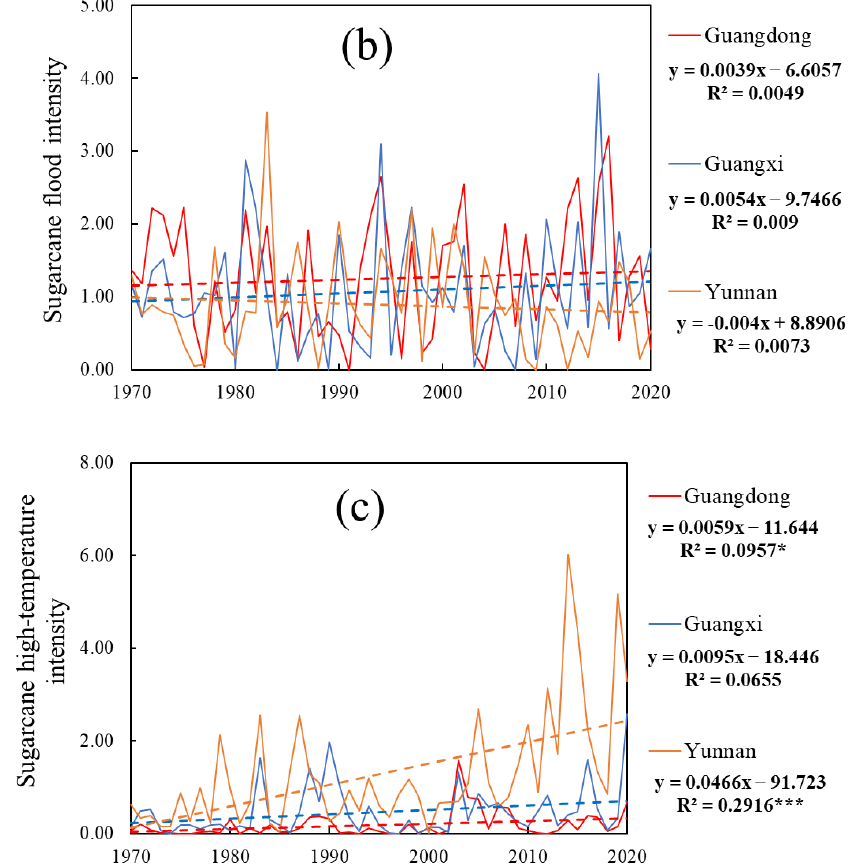
Figure 4. Temporal trends of drought ( a ), flood ( b ), and high temperatures ( c ) during sugarcane growth stages in Guangdong, Guangxi, and Yunnan provinces. The calculation sample size of every regression model is 51 (from 1971 to 2020). * and *** indicate p < 0.05 and p < 0.001. The regression model in Guangxi is significant at p < 0.10.